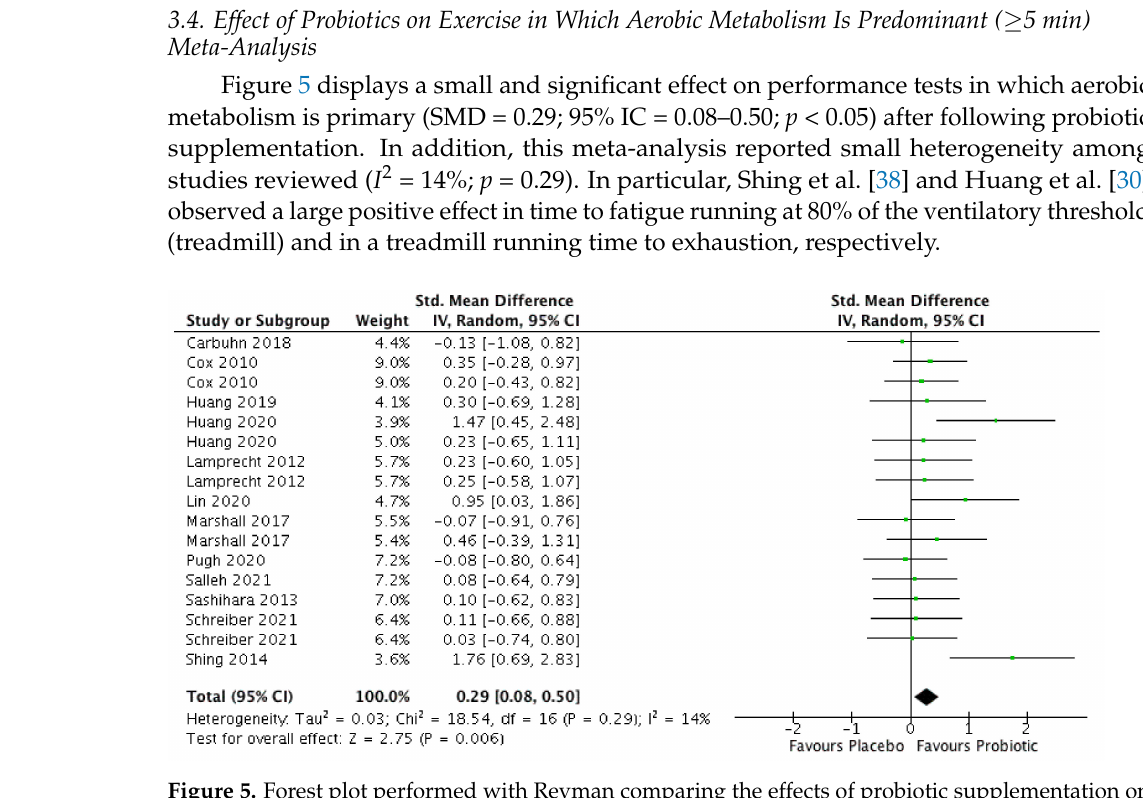
Figure 5. Forest plot performed with Revman comparing the effects of probiotic supplementation on tests in which the aerobic metabolism is